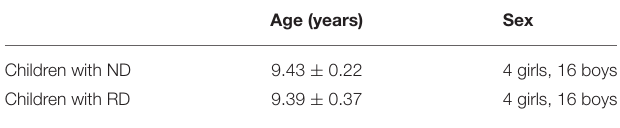
TABLE 1 | Age (mean and standard error) and sex of the two groups of children